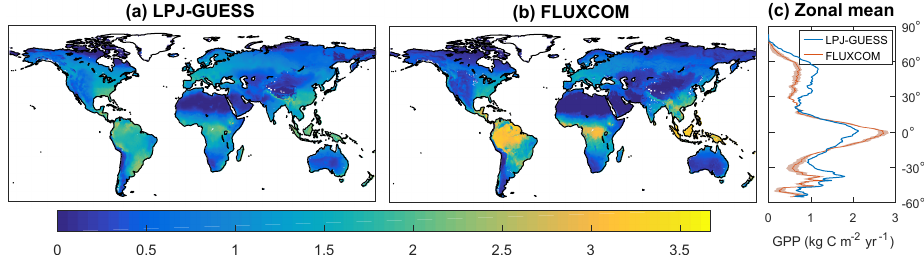
Figure 8. Mean gross primary productivity (GPP) for 1997–2006. (a) LPJ-GUESS GPP for the true historical simulation ( + Ndep + clim + CO 2 ). (b) FLUXCOM GPP (Jung et al., 2017), mean over six approaches. (c) Latitudinal averages. The shaded area for FLUXCOM indicates the 95% confidence range over the six approaches.